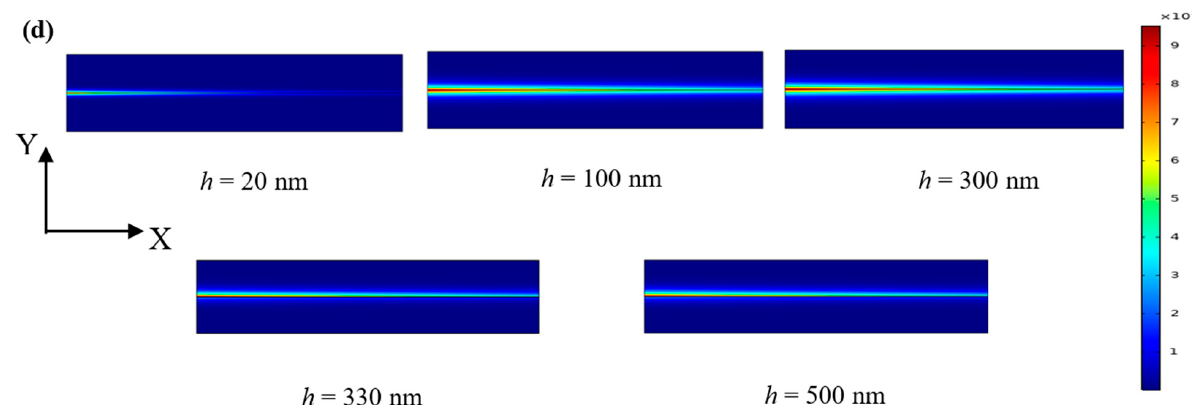
Figure 2. ( a ) The real parts of effective mode index ( N ef f ) of symmetric silica-gold-silica (blue curve) and asymmetric air-gold-silica (magenta curve) DMD structures as a function of gold thickness ( h ). The dashed line and the dash-dotted line show the refractive index of silica and the effective mode index of a single silica-gold interface. ( b ) Propagation length ( L SPP ) of DMD structures versus gold thickness. ( c ) The fraction of guided electromagnetic energy in gold versus h . ( d ) Illustration of the electric field distribution (norm E) for different gold thicknesses for silica-gold-silica (symmetric structure). The lateral and vertical simulation domain sizes in ( d ) are 1 mm and 200 µm, respectively. Blue regions correspond to low field intensities and red regions to larger intensities.